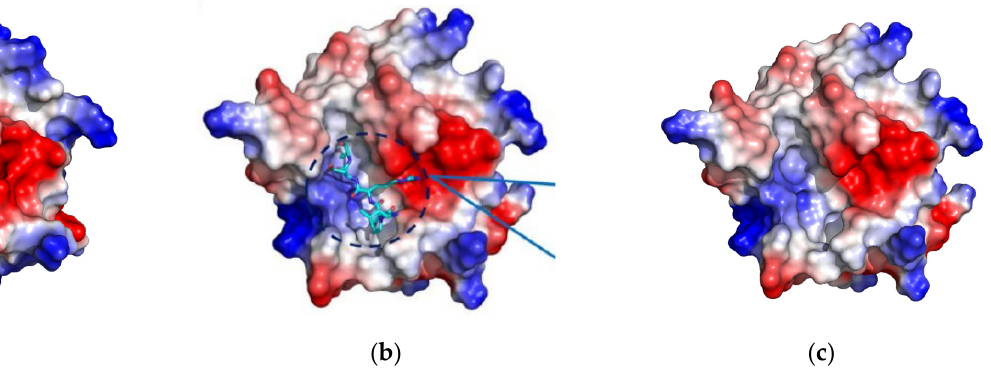
Figure 9. Surface models of PDB:1T2P ( a ) and PDB:1T2W ( c ) in comparison with the figure (Figure